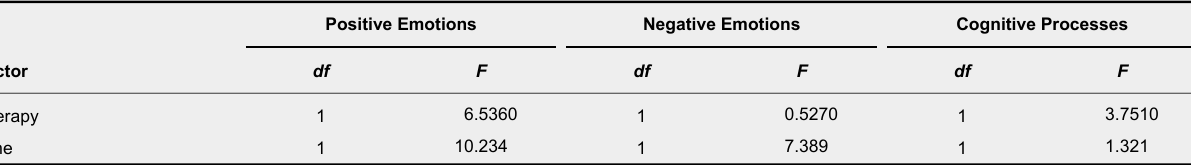
Repeated Measures ANOVA: Main Effects Between Groups, Related to the Linguistic Categories (Positive Emotions, Negative Emotions, Cognitive Processes) for Therapy and